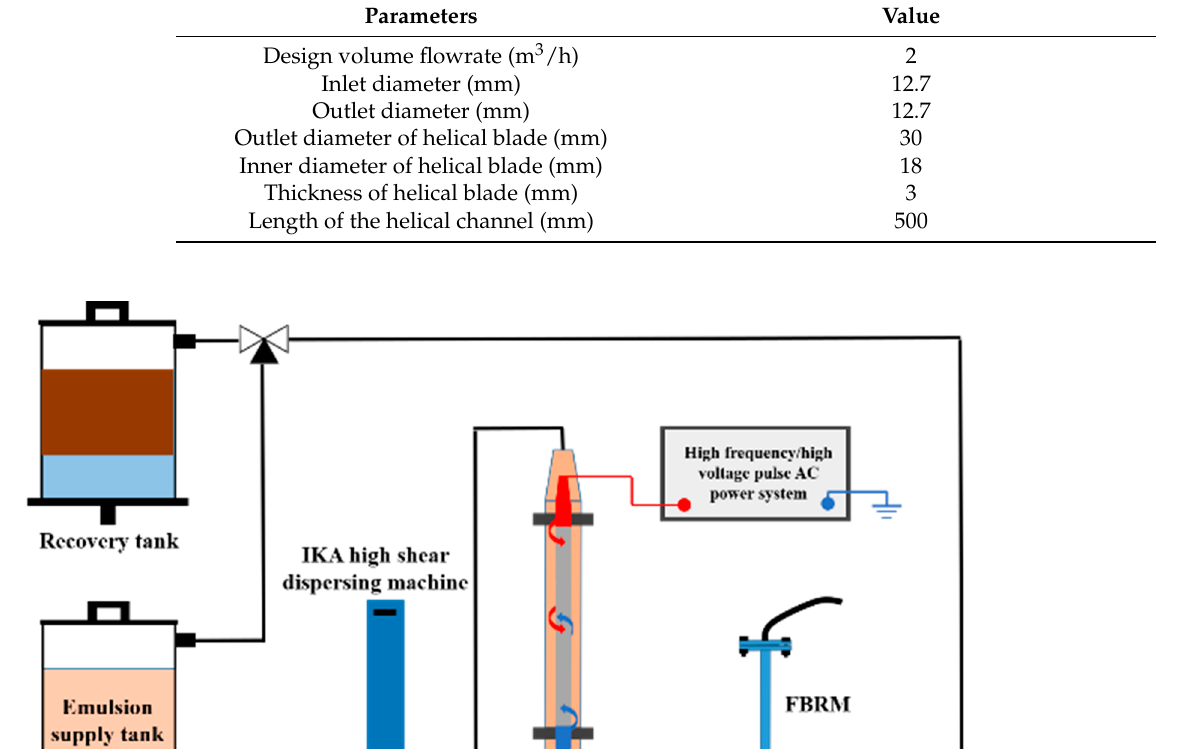
Figure 2. Experimental chart of test system. Table 1. The main parameters of compact electrostatic coalescer.